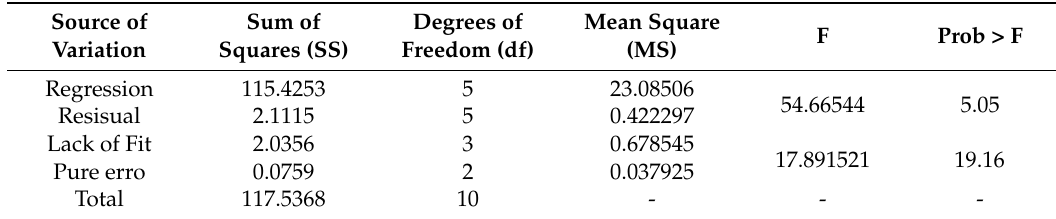
Table 4. Analysis of